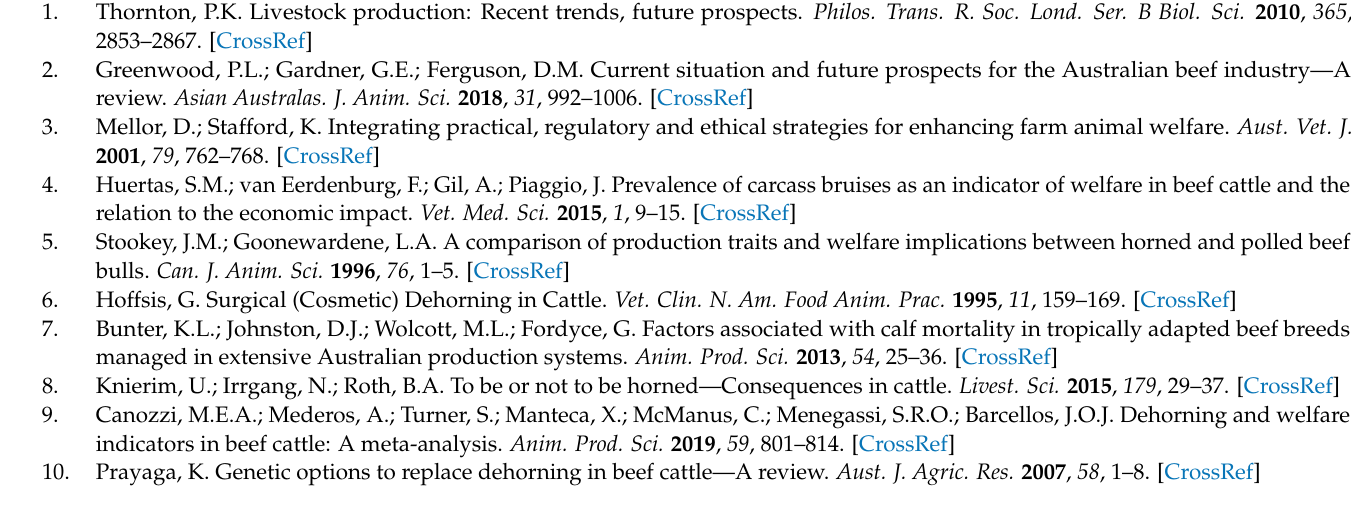
area EBVs (accuracy ≥ 50%) for horn and poll cohorts, Figure S8. Boxplots of intra-muscular-fat EBVs (accuracy ≥ 50%) for horn and poll cohorts born 2000–2018, Figure S9. Boxplots of rib fat EBVs (accuracy ≥ 50%) for horn and poll cohorts, Figure S10. Violin-plots of BREEDPLAN EBVs (accuracy ≥ 70%) of weight traits at different life-stages in eight breeds comparing horn and poll cohorts. Pink steric (*) represent a statistically significant higher mean at 70% accuracies of EBVs, Figure S11. Effect sizes (Cohen’s d ) of polledness in 8 breeds using BREEDPLAN EBVs (accuracy ≥ 70%) on 12 production traits. Red lines within each bar show 95% confidence intervals of effect sizes. Statistically significant results are shown with a red star, Table S1 Breed-wise sample sizes (N animals) used for the combined, polled, and horned cohorts, their Mean, Standard deviation (SD), standard error of mean (SEM), lower and upper 95% confidence intervals (CI) of mean, T-test, p -value, Point biserial correlation, Effect size (ES), and lower and upper 95% CI of ES of 12 traits at 50% and 70% accuracy of EBVs using animals born before and after year 2000. Table S2 Breed-wise overall changes in the EBVs of each trait during 2000 (start) to 2018 (end) at 50% and 70%